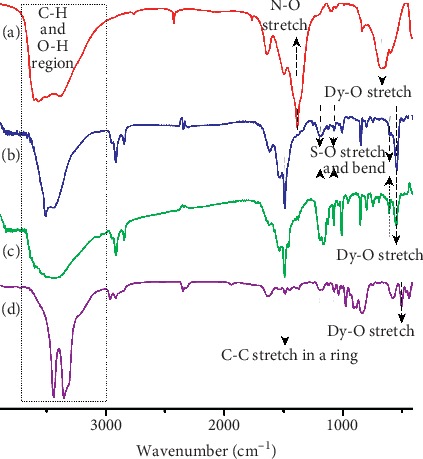
FTIR patterns of (a) Dy2(OH)5(H2O)nNO3.nH2O, (b) Dy2(OH)5 (C28H20O6S2)0.5.nH2O, (c) Dy2(OH)5(C28H20O6S2)0.5@Pb.nH2O, and (d) Dy2 (OH)5(C28H20O6S2)0.5@Cu.nH2O.